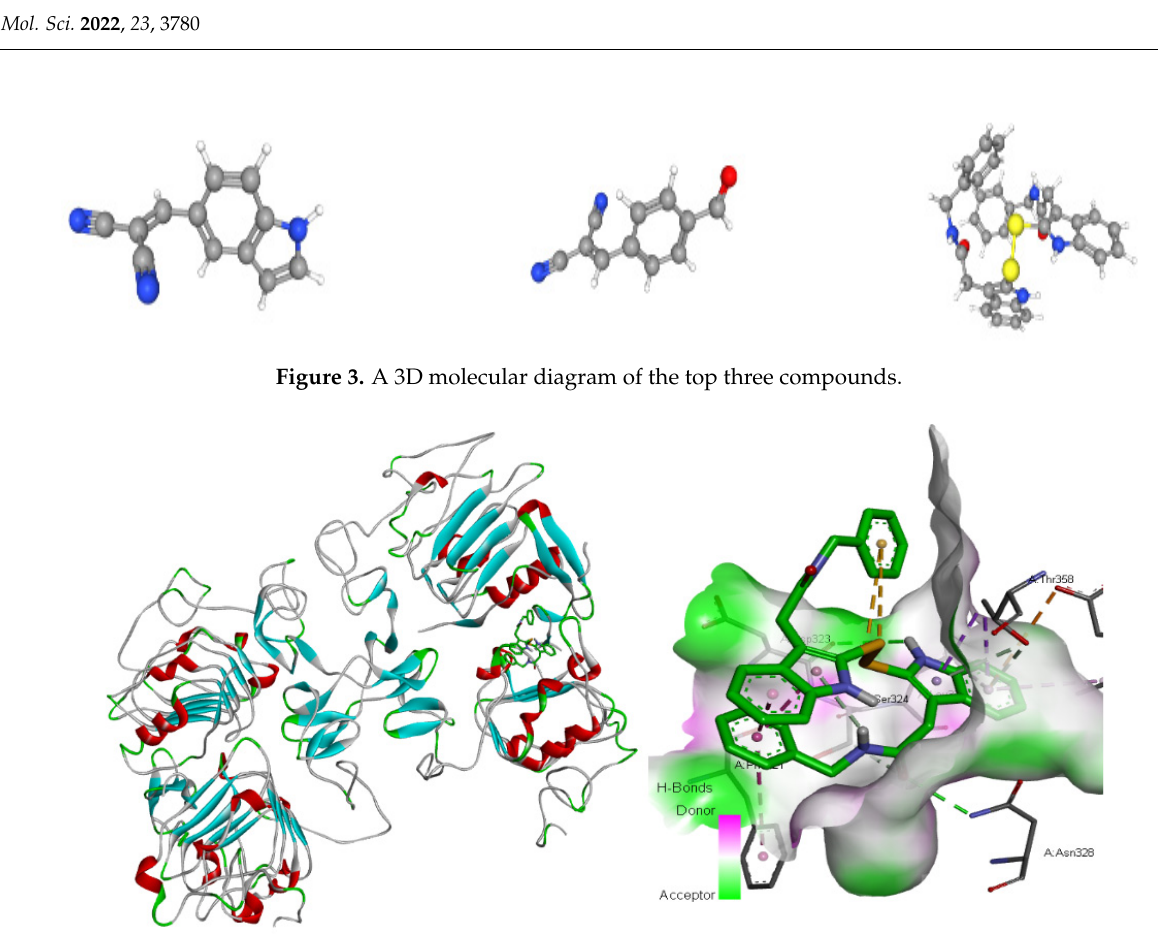
Figure 4. Docking diagram of C 34 H 30 N 4 O 2 S 2 molecule and EGF receptor protein.